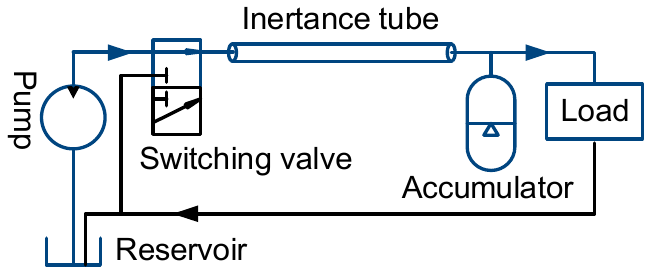
Figure 1. Schematic of three-port flow booster.